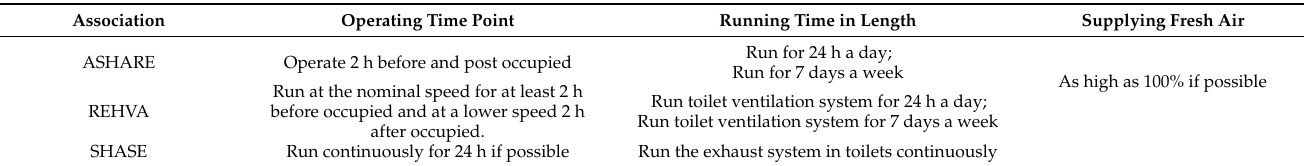
Table 1. The recommended strategies for ventilation system